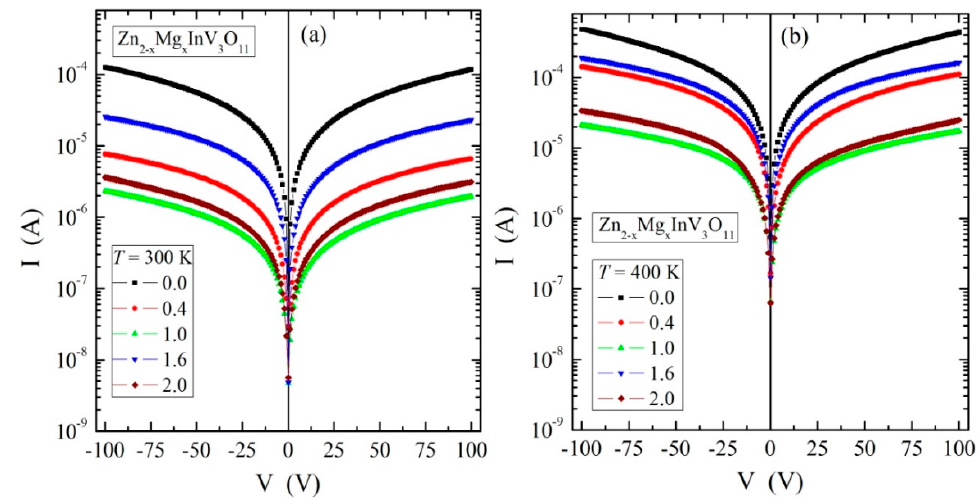
Figure 5. The I–V characteristics at 300 ( a ) and 400 K ( b ) of Zn 2 − x Mg x InV 3 O 11 .